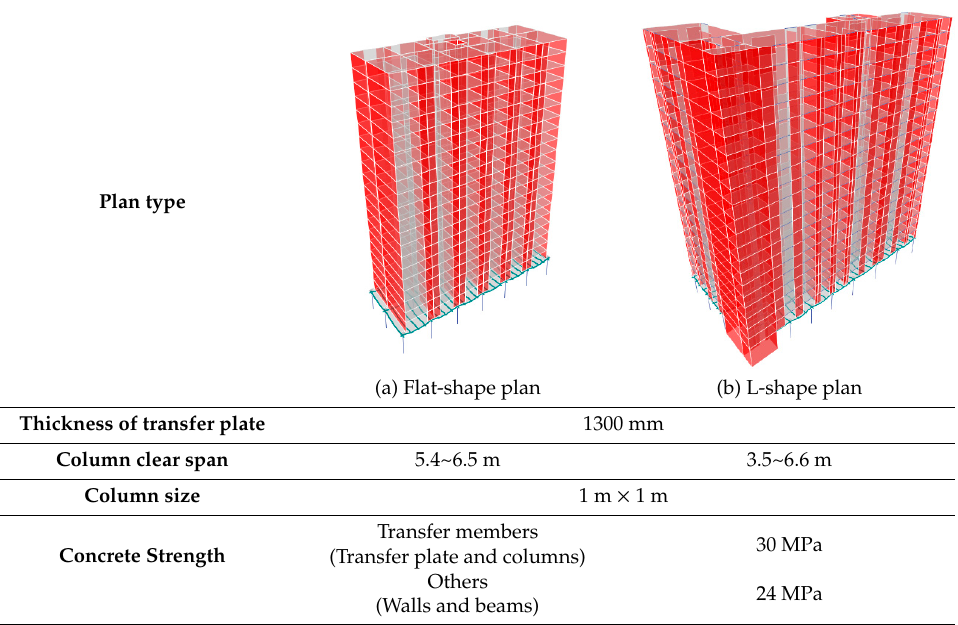
Figure 5. Calculation of direct shear and unbalanced moment at the slab-column connection.